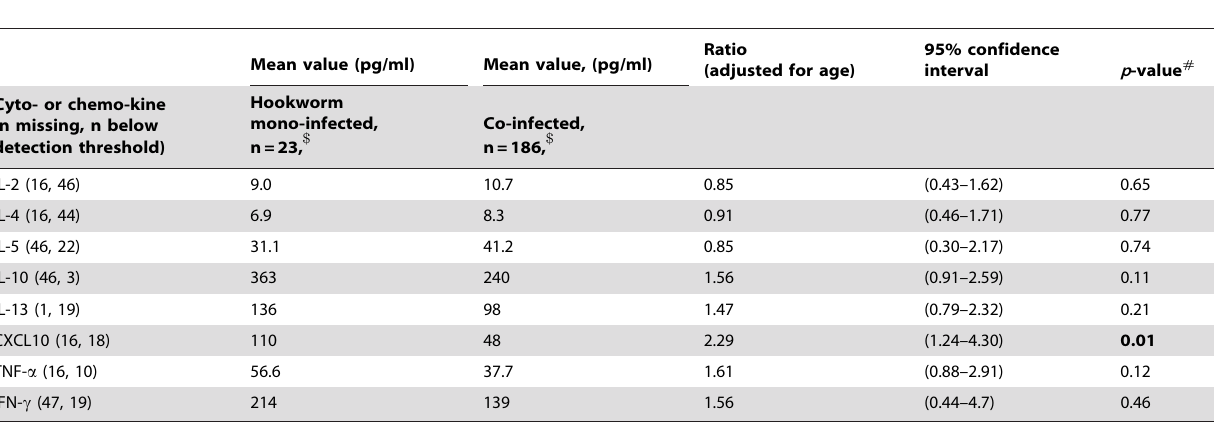
Table 5. L3 antigen-induced cytokine and chemokine secretion in lymphocyte cultures from individuals mono- or co-infected with hookworm.